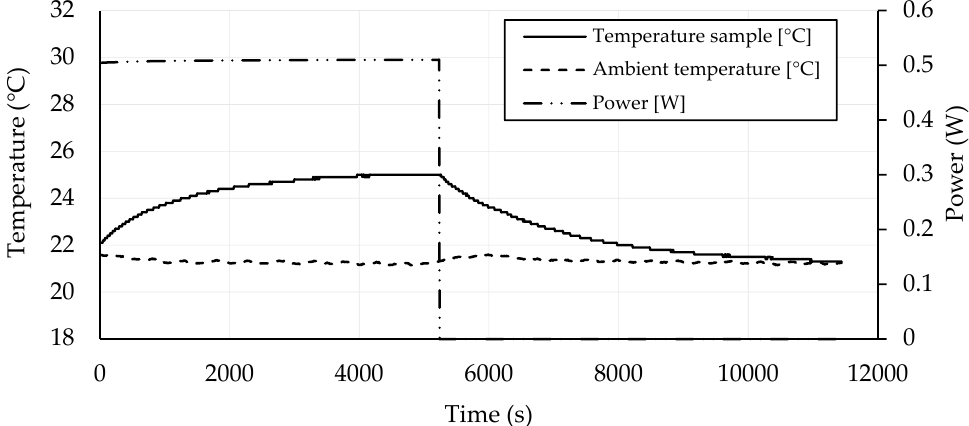
Figure 9. Self-heating experiment—CB 1.75, 40 V.